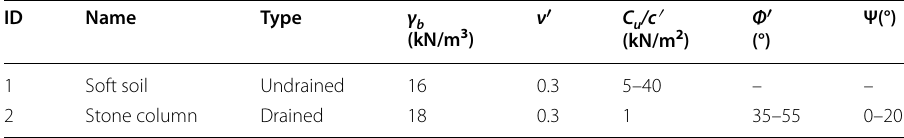
Table 1 Materials properties of the soil model